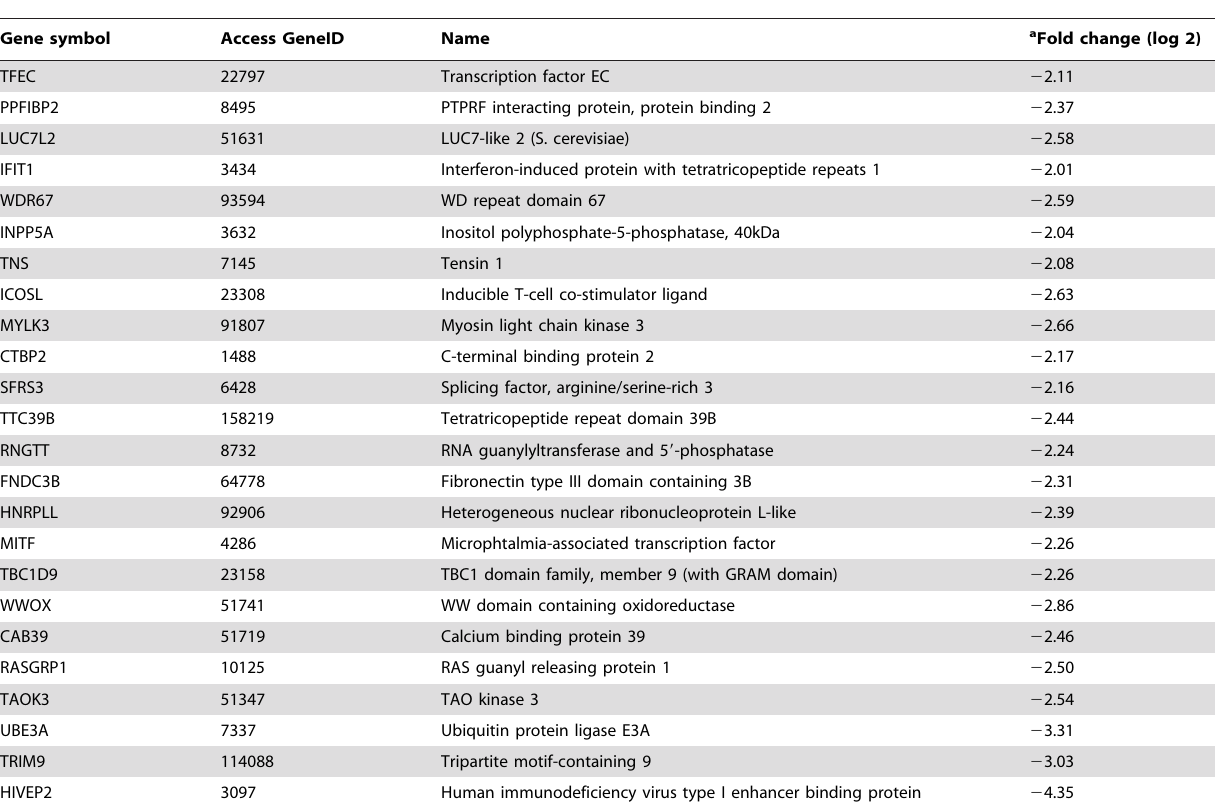
Table 2. Downregulated genes in UV irradiated DCs vs non irradiated DCs.